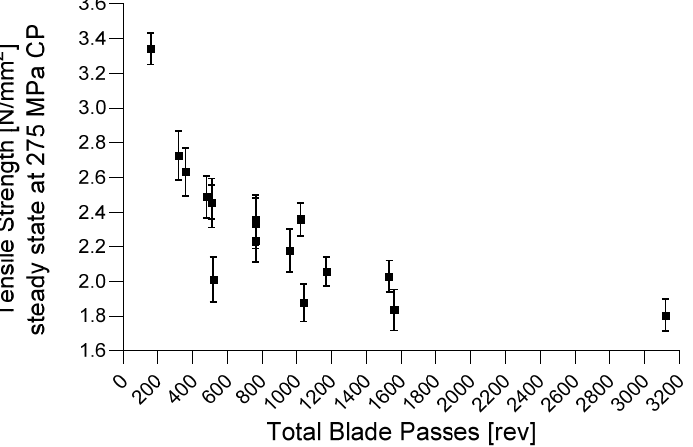
Figure 18. TS as a function of TBP at 275 MPa compression pressure.